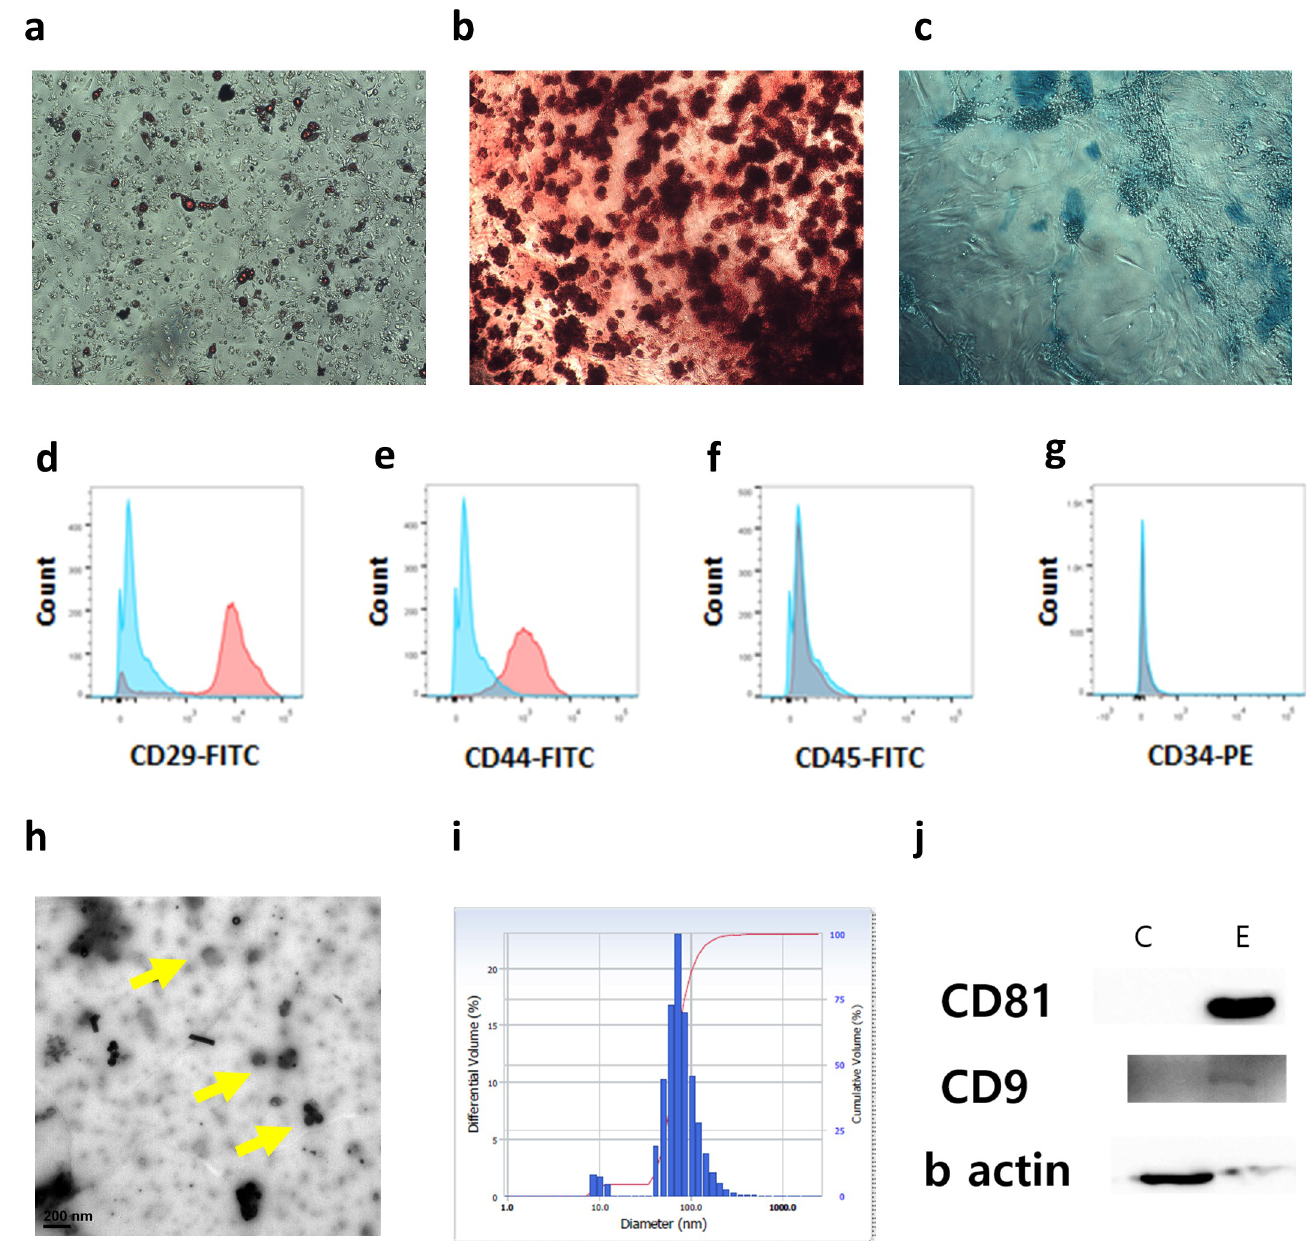
Fig 1. cAT-MSC characterization and cAT-MSC derived EV characterization. To identify multilineage differentiation, cAT-MSC were differentiated into (a) adipocyte, (b) osteocyte and (c) chondrocyte. Differentiated cells were stained each specific dye. (d-g) To immunotype, the markers of cAT-MCS were analyzed with CD29, CD44 as positive and CD45, CD 34 as negative. (h) In electron microscopic analysis, EVs were measured as 50-100nm. (i) Through a particles-size analyzer, the diameter of EVs was confirmed as around 100nm. (j) CD81 and CD 9, surface marker of EV, were confirmed as positive and β -actin was confirmed as negative in western